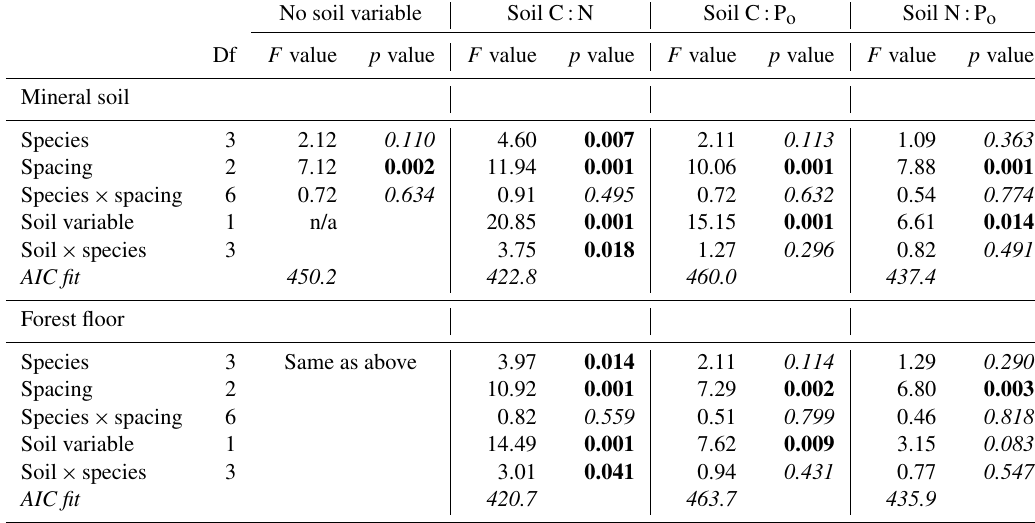
Figure 2. Trends in C:N molar ratios of (a) mineral soil (0–20cm) and (b) forest floors in relation to substrate C concentrations. Table 3. Conifer species basal area (m 2 ha − 1 ) in 2014 (stand age 52 years) in relation to planting density (1329, 748 and 479 stemsha − 1 ) and mineral soil (0–20cm) or forest floor resource stoichiometry (as molar ratios; p values<0.05 in bold; AIC fit values shown in italics). No soil variable Soil C:N Soil C:P o Soil N:P